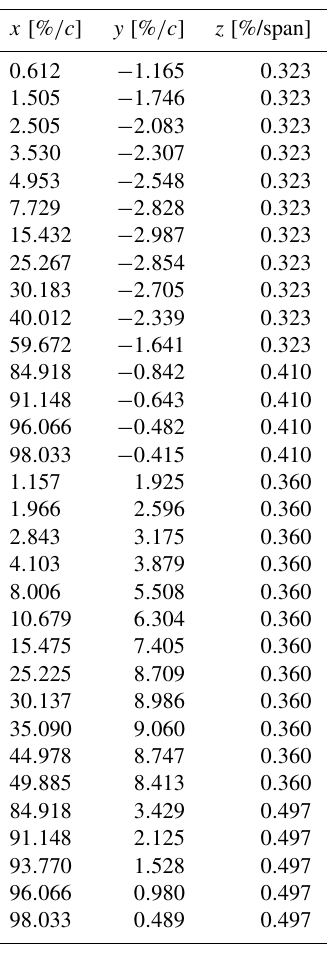
Table B1. Coordinates of the pressure taps in reference to the chord and the spanwise position. The according coordinate system is lo- cated at the leading edge at the lower spanwise end of the model.